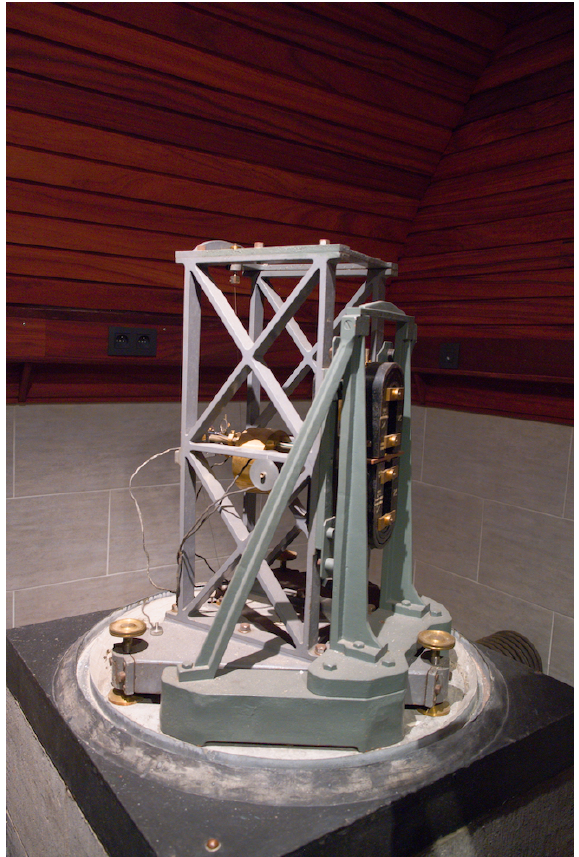
Figure 2. Instrument used for data capture in 1954: Horizontal Galitzine seismometer located in UCC. Image source: courtesy of ROB. Photo source: R. S. M. De